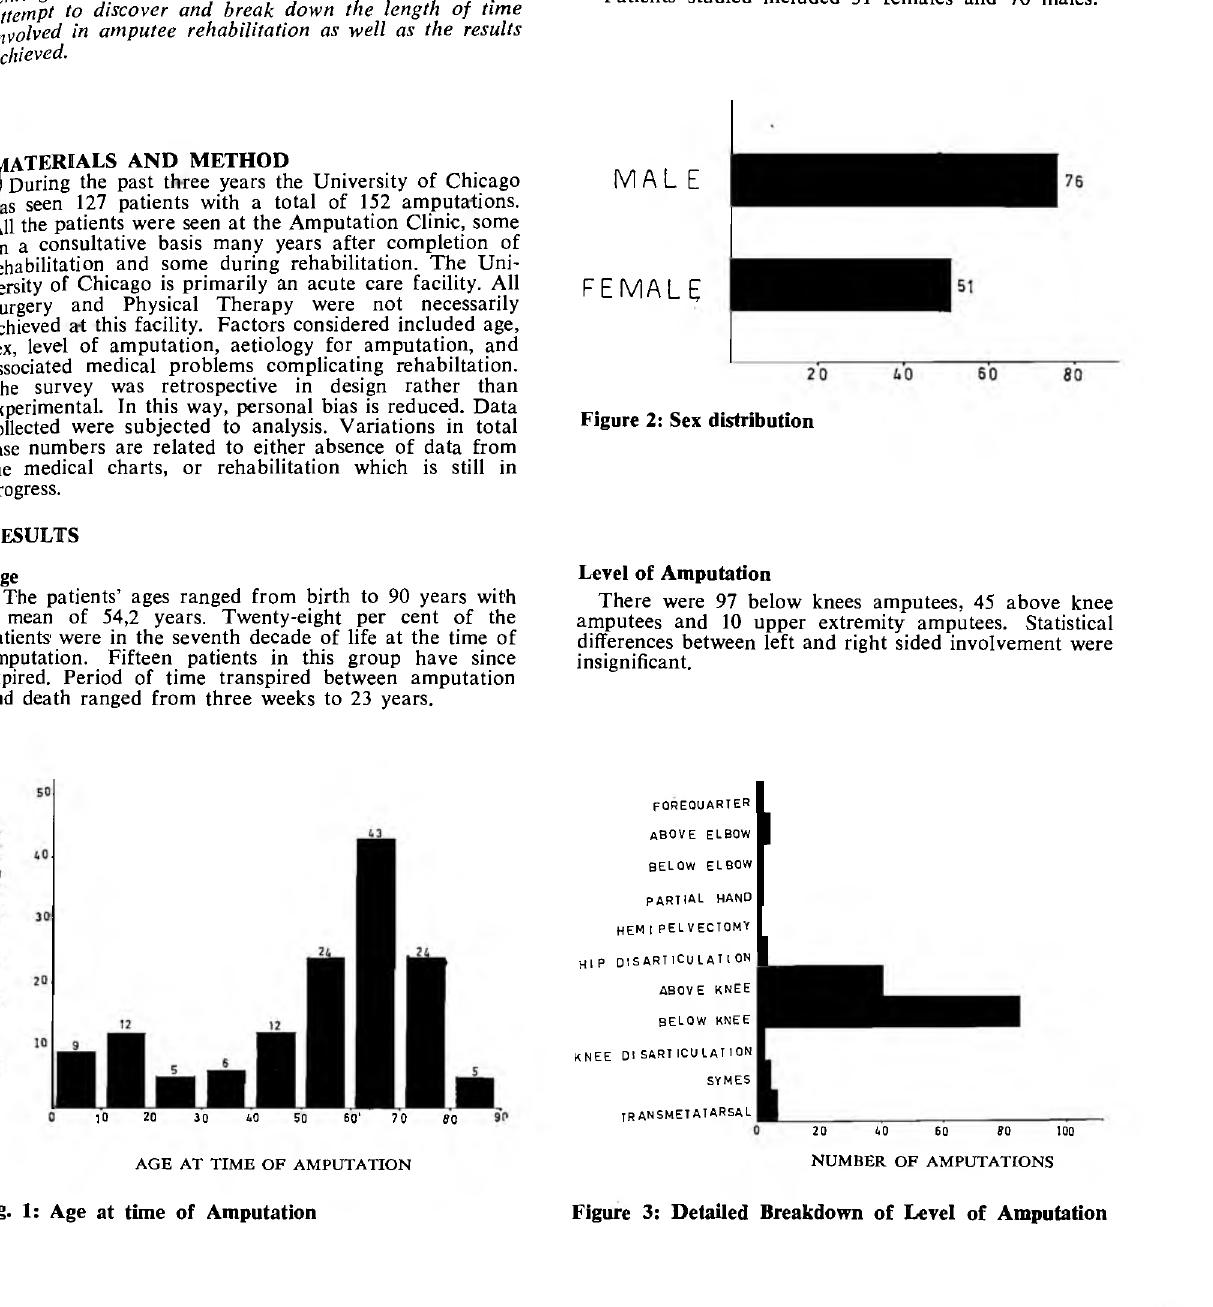
Fig. 1: Age at time of Amputation Figure 3: Detailed Breakdown of Level of